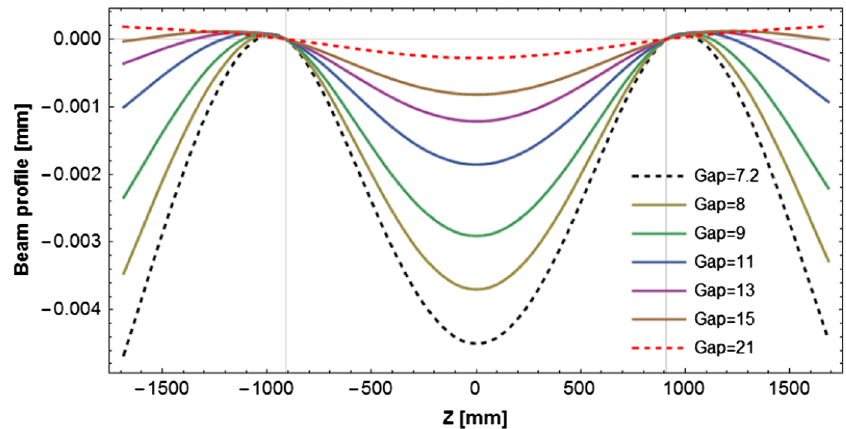
FIG. 5. Analytical calculation of the strongback deformation for optimized actuator locations assuming ideal spring units. The vertical lines mark the actuator